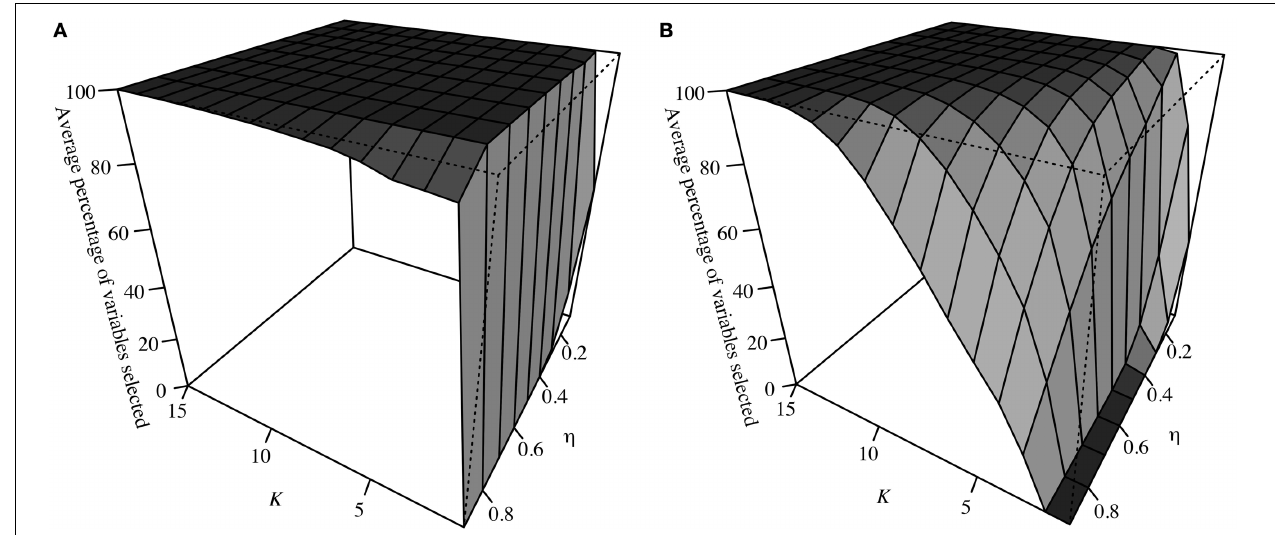
FIGURE 1 | (A) shows the average percentage of variables in S 2 selected for each pair of tuning parameters across D = 1000 simulated data sets, while (B) shows this for S 3